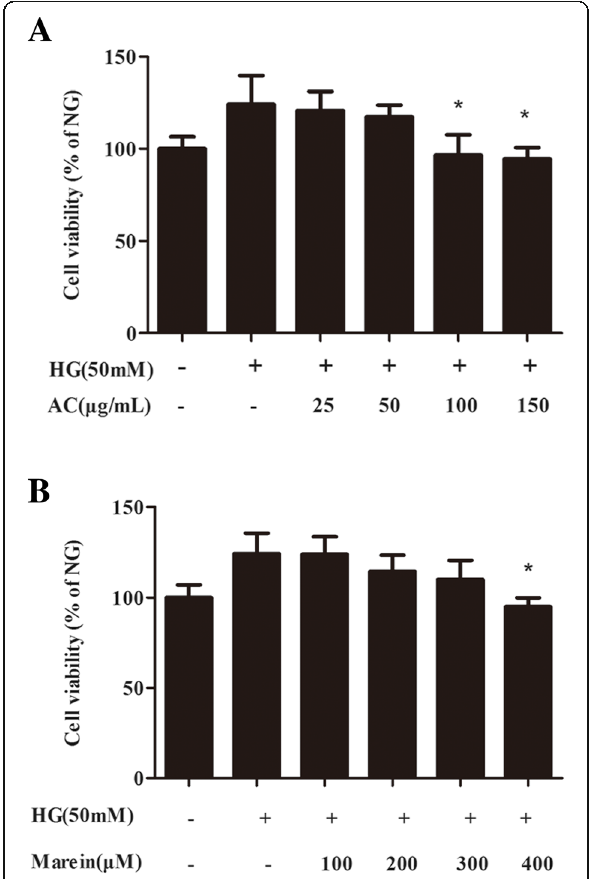
Fig. 1 a Inhibitory effect of AC on cell proliferation in HG-treated HBZY-1 cells by the CCK8 assay. b Inhibitory effect of marein on cell proliferation in HG-treated HBZY-1 cells by the CCK8 assay. Note: Values of cell proliferation among the groups were analyzed as described previously in Materials and methods. Values were expressed as the mean ± SD, n = 4. # P < 0.01 versus normal group; * P < 0.05 versus control group; ** P < 0.01 versus control